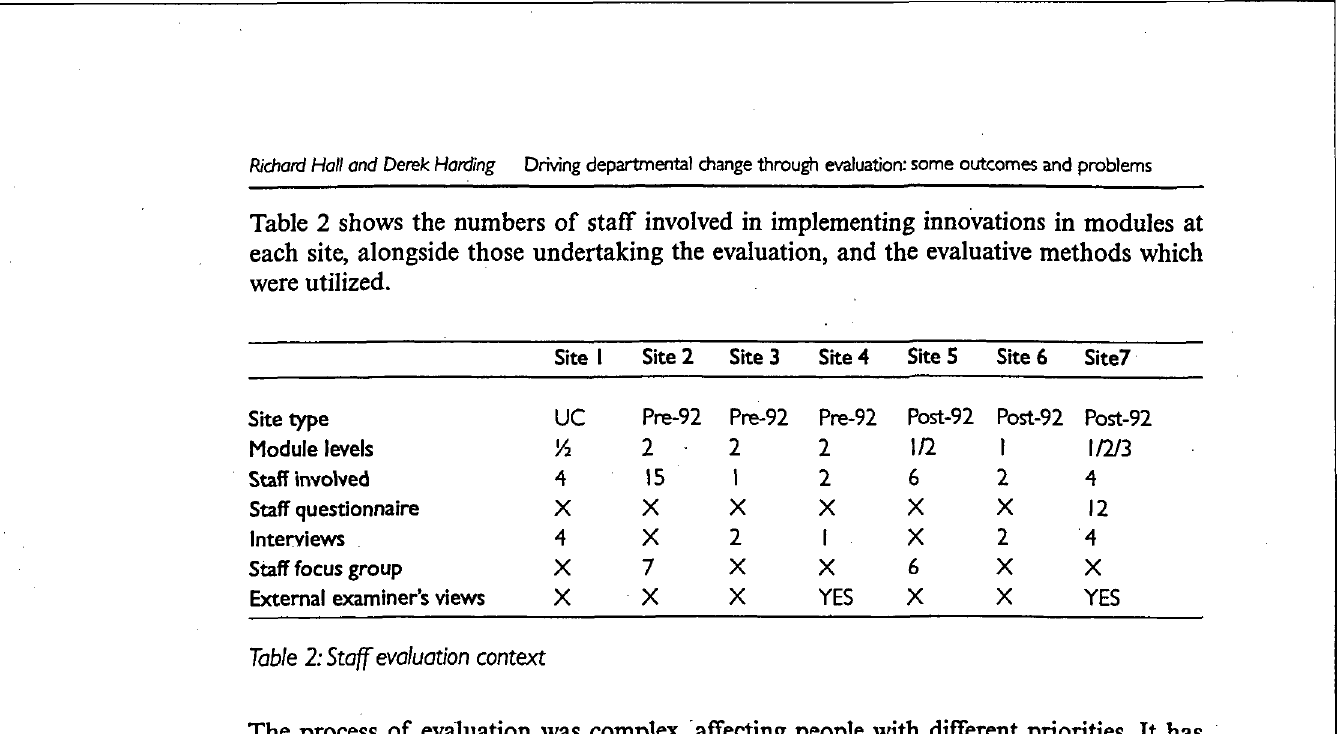
Table 2: Staff evaluation